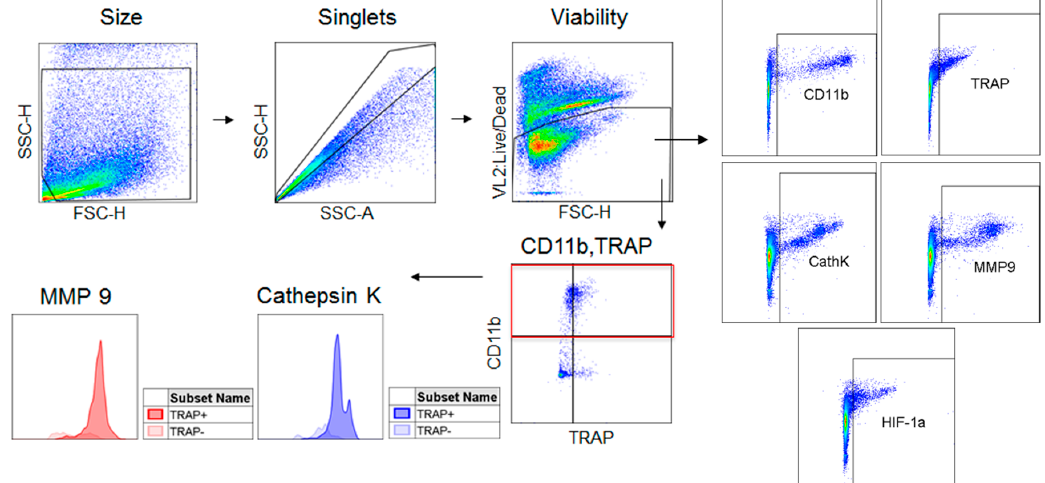
Figure 1 . Flow cytometry gating strategy. Cells derived from culture or tissue samples were gated for size, singlets, and viability. Live cells were then analyzed for their expression of CD11b, TRAP, cathepsin K, MMP-9, and HIF-1 α . The CD11b + population was divided into TRAP − and TRAP + populations which were analyzed for their expression of cathepsin K and MMP-9.